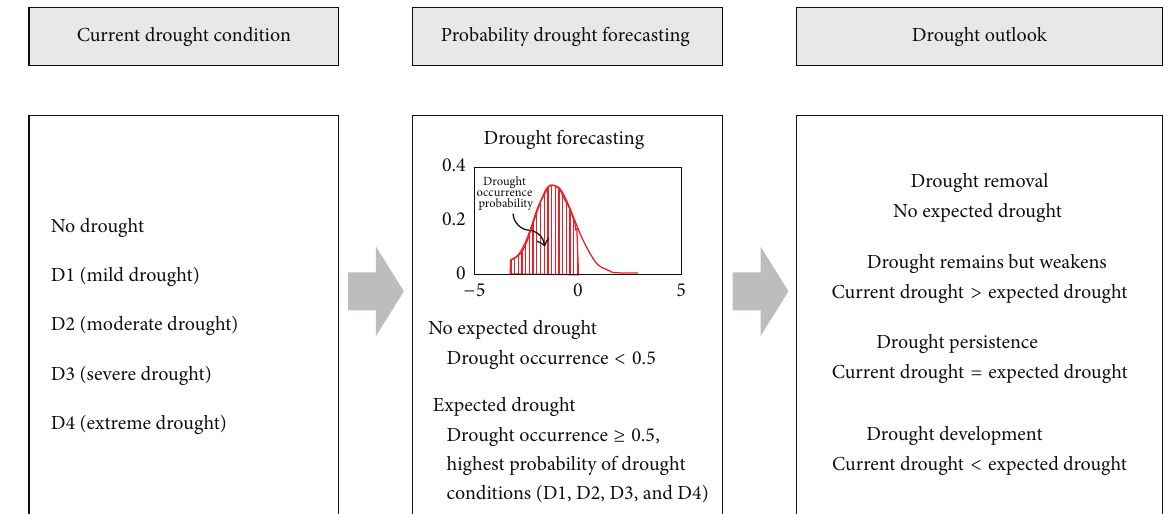
Figure 6: Drought outlook framework using the BNDF results.